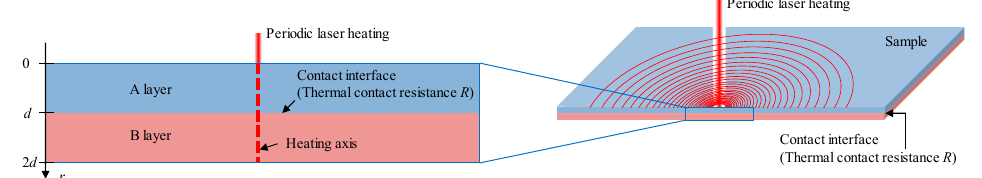
Figure 1. Schematic of TCR measurement